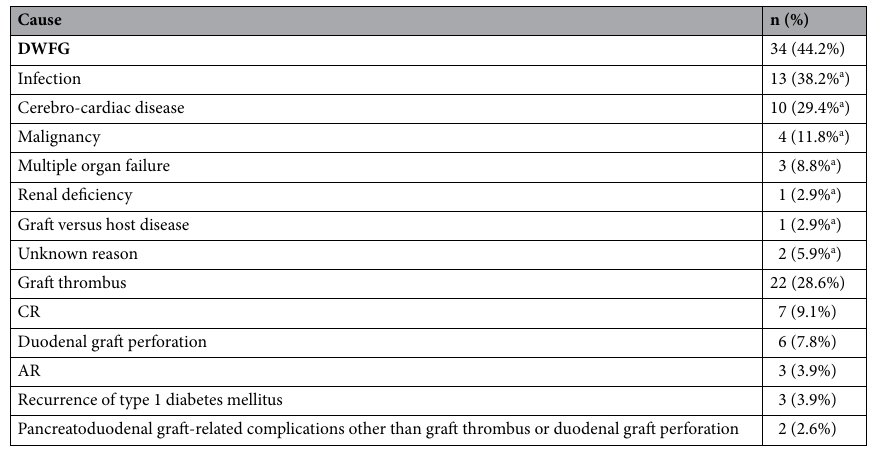
Table 1. Cause of pancreas graft loss including cause of the DWFG in cases after PTx. AR acute rejection, CR chronic rejection, DWFG death with a functioning graft, PTx pancreas transplantation. a Percentage of all DWFG cases.